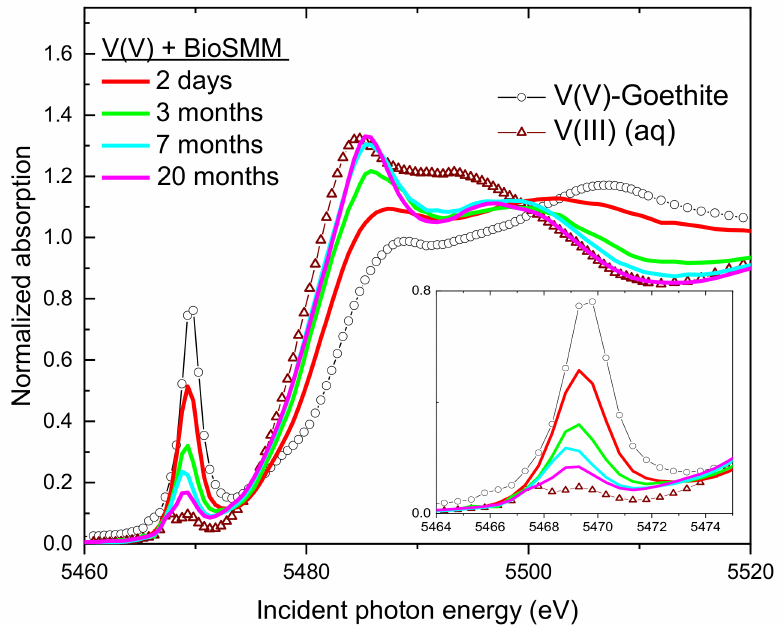
Figure 9. The V K-edge XANES spectra of the solids in the biogenic siderite/mackinawite/magnetite (BioSMM) system over time compared to representative standards V(V) sorbed to goethite and aqueous V(III). Inset shows details in the pre-edge